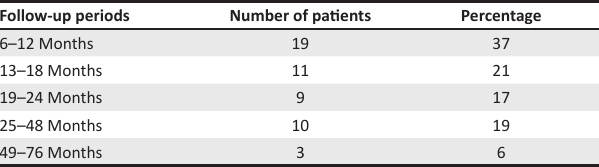
TABLE 5: Postoperative follow-up periods of study patients in percentages. Follow-up